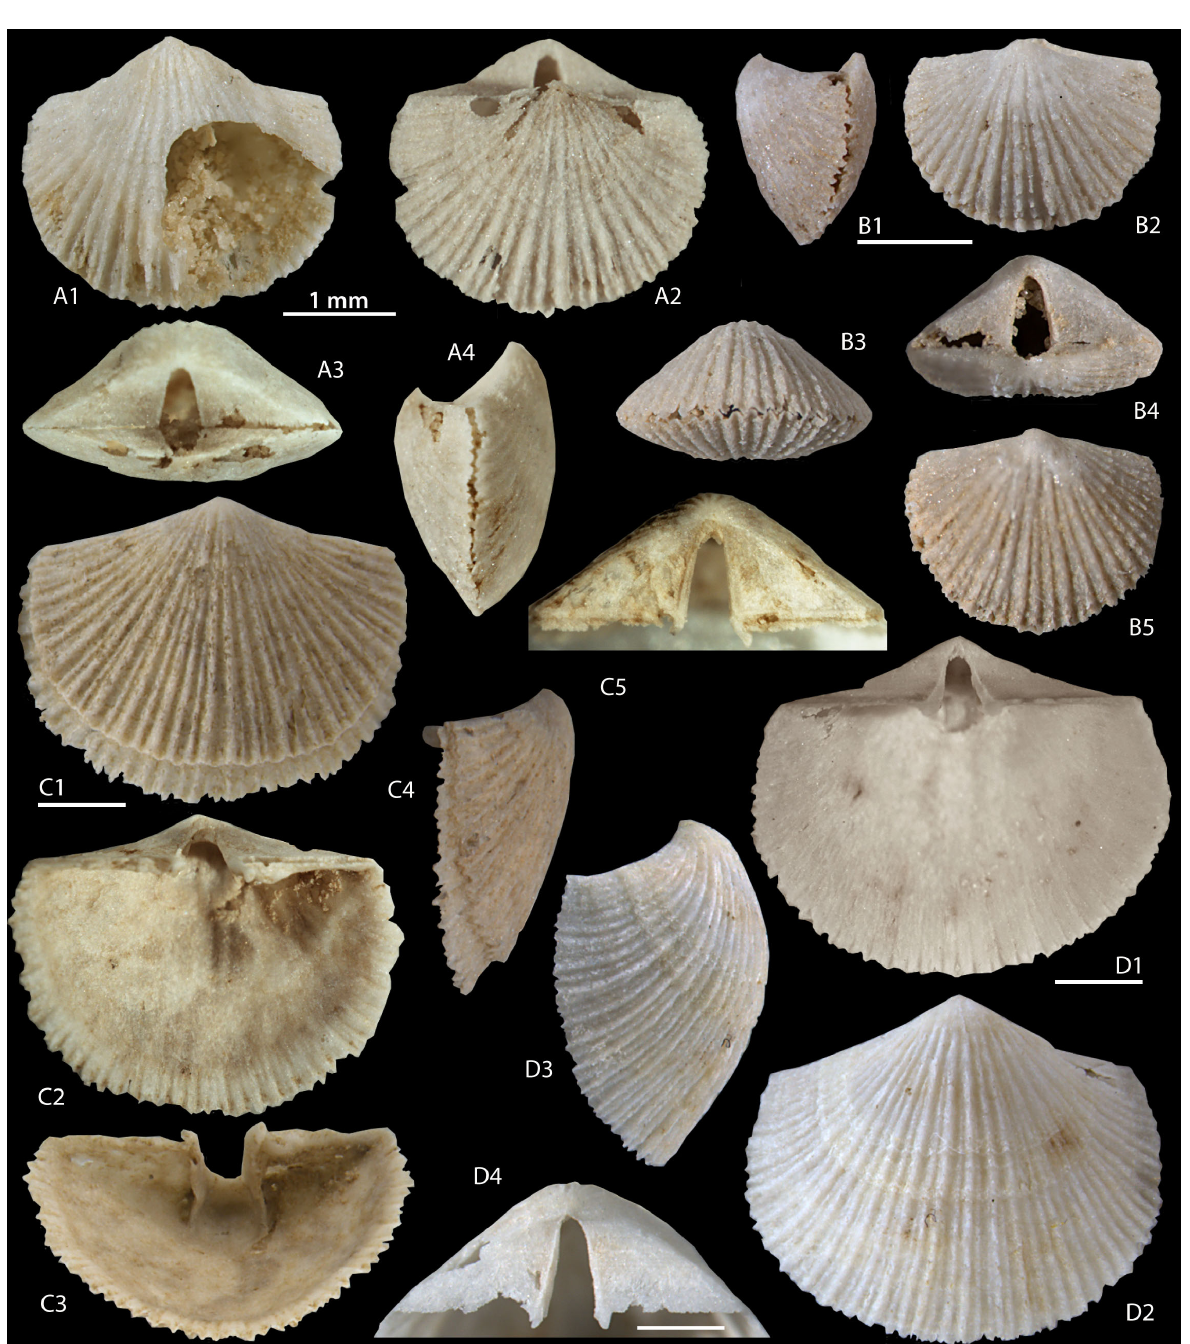
Fig. 2. A(cid:150)D , Sigmelasma peepi sp. nov. Porkuni quarry, Porkuni Stage, ˜rina Formation, Siuge Member. A1(cid:150)4, conjoined valves GIT 626-45, ventral, dorsal, posterior and lateral views. B1(cid:150)5, conjoined valves GIT 626-47, lateral, ventral, anterior, posterior and dorsal views. C1(cid:150)5, ventral valve GIT 626-26, exterior, interior, antero-posterior and lateral views. D1(cid:150)4, ventral valve GIT 626-25, interior, exterior, lateral and posterior views. Fig. 3. A(cid:150)E , Sigmelasma peepi sp. nov. Porkuni quarry, Porkuni Stage, ˜rina Formation, Siuge Member. A1(cid:150)5, dorsal valve GIT 626-22, A1 and A2 (cid:150) exterior and interior views, A3(cid:150)5, tilted views of cardinalia. B1(cid:150)3, dorsal valve GIT 626-18, exterior and interior views. C1(cid:150)3, holotype, dorsal valve GIT 626-16, interior and exterior views, posterior view of cardinalia. D1, 2, incomplete dorsal valve GIT 626-20, exterior and interior views. E1, 2, dorsal valve GIT 626-14, interior and exterior